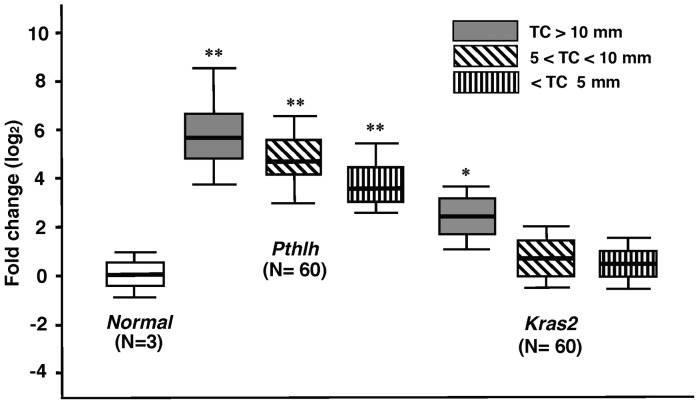
Quantitative analysis of Pthlh and Kras2 mRNA levels in F1 tongue cancer (TC): TC >10 mm, TC 5–10 mm, TC <5 mm and non-TC tissue F1 samples. The line within each box represents the median fold change. The upper and lower edges of each box represent the 75th and 25th percentiles, respectively. The upper and lower bars represent the highest and lowest value determined, respectively. **P<0.001, *P<0.01.